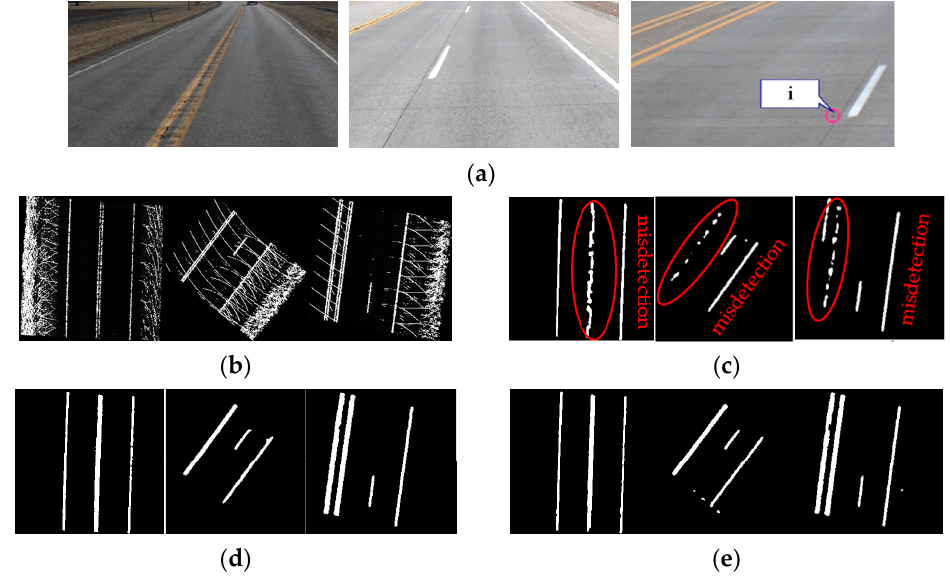
Figure 19. Improved prediction in fine-tuned models compared to pretrained model: ( a ) RGB im- ages of new lane marking patterns in target domain dataset segments; ( b ) corresponding intensity images; ( c ) pretrained U-net predictions with highlighted misdetection; ( d ) encoder-trained U-net predictions; ( e ) decoder-trained U-net predictions.